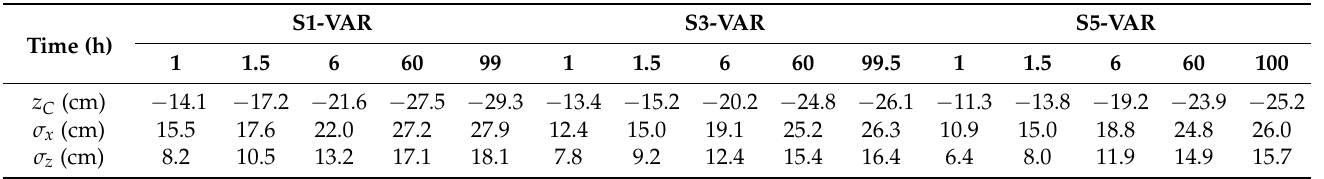
Table 6. The location of the center of mass, z C , and the semi axes of the ellipses, σ x and σ z , with variable (VAR) ponding depth at stations 1 (S1), 3 (S3), and 5 (S5).